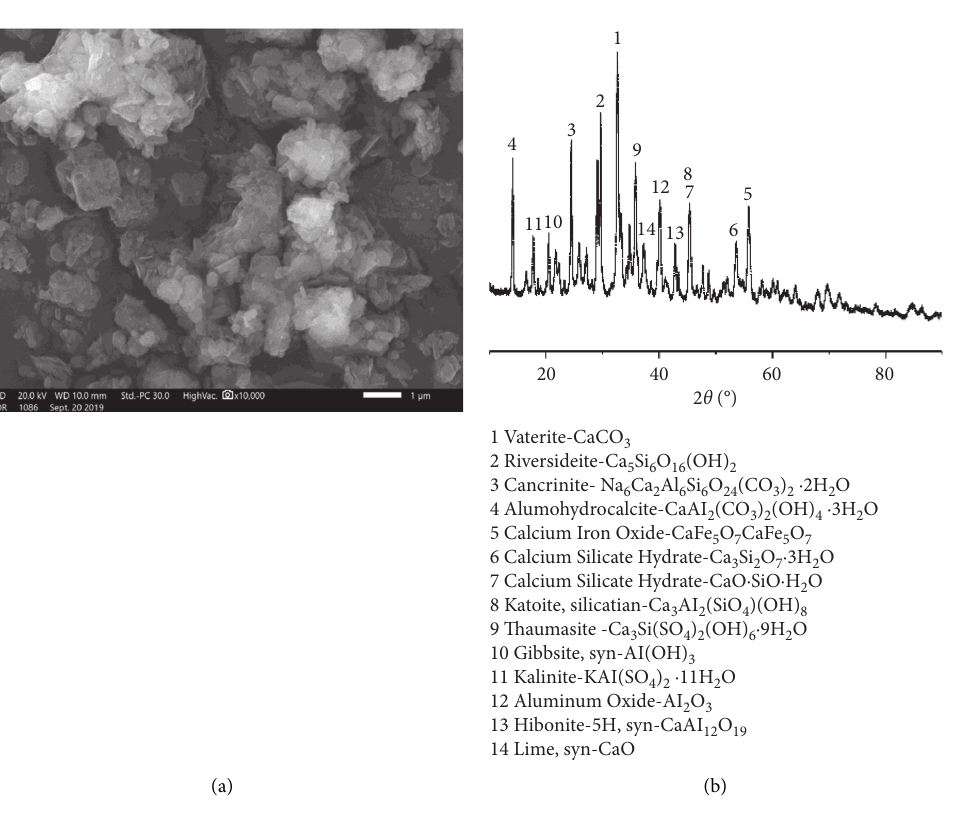
Figure 1: SEM and XRD analyses of red mud. (a) SEM image × 10000. (b) XRD pattern.